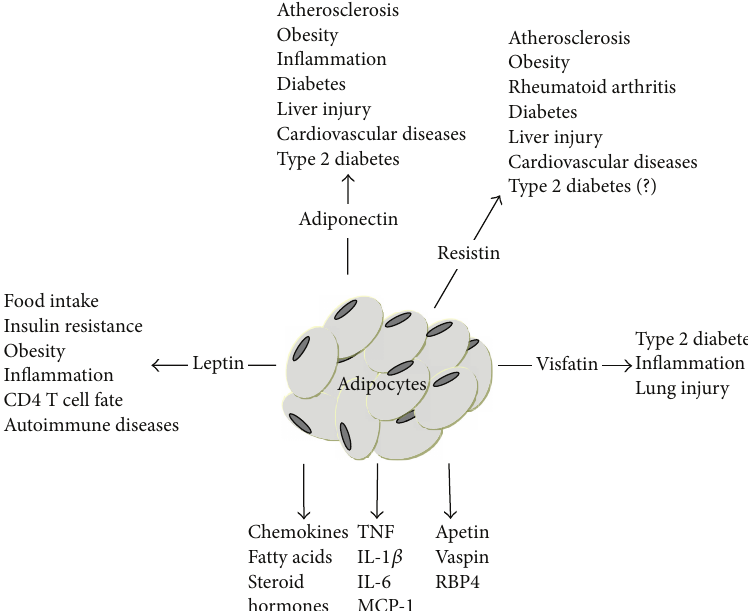
Figure 2: The adipose tissue secretes several hormone-like molecules called adipokines. Adipokines are pleiotropic molecules, participating in body physiology regulation. Adipokines also play a role in several diseases such as diabetes, atherosclerosis, and autoimmune diseases, among